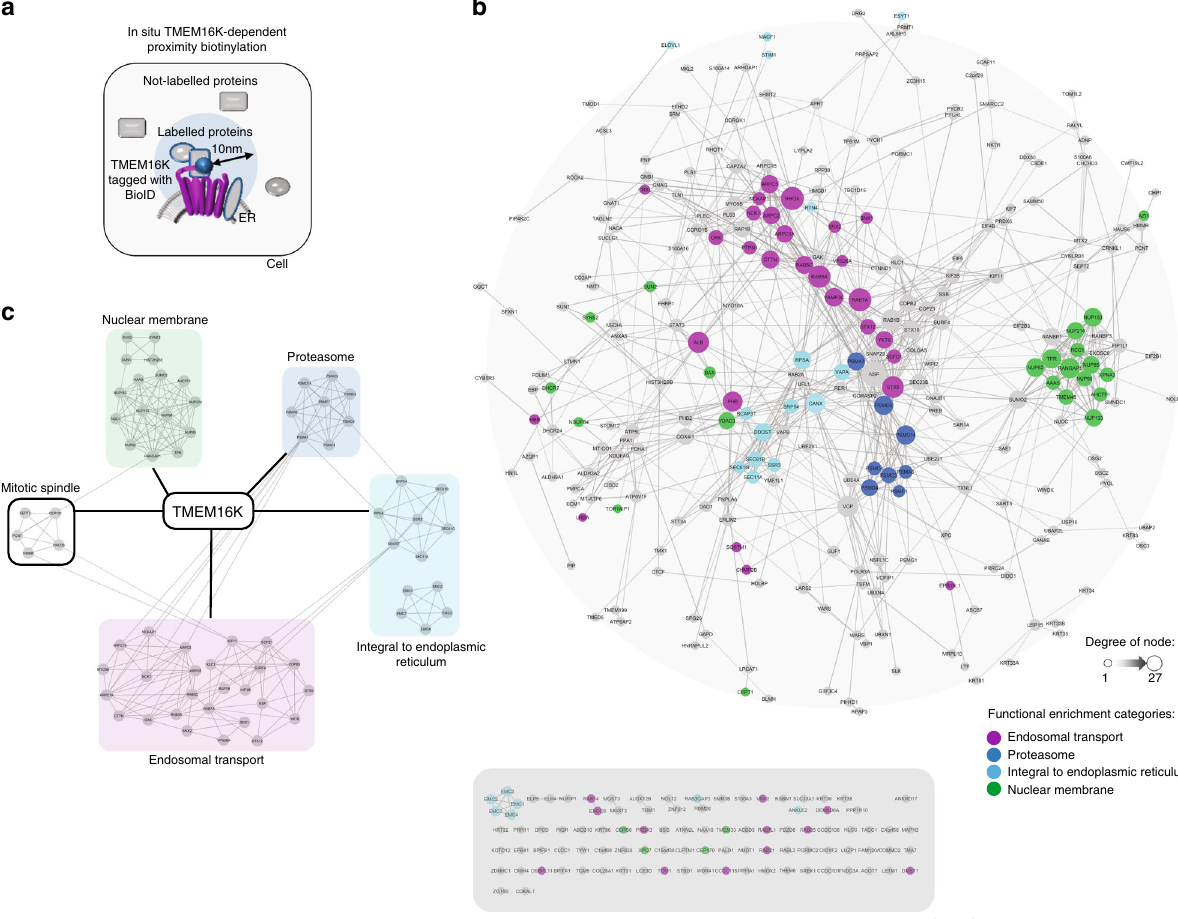
Fig. 2 Proteomic mapping of TMEM16K via in situ BioID-catalyzed biotin labeling fi nds endosomal transport as a major functional cluster. a Scheme of proteomic mapping of protein complexes surrounding TMEM16K in the radius of 10 nm via in situ proximity biotinylation. b TMEM16K proteome candidate list is visualized as a protein-protein interaction network using the String protein interaction public database in Cytoscape. Candidates without known protein-protein interactions in the String database are represented on the bottom in the gray panel. TMEM16K is omitted from this representation for simplicity. Functional enrichment based on the GO terms was calculated using the String app in the Cytoscape and the major identi fi ed categories of functional enrichment were overlayed on our candidates with color-code. Purple: Endosomal transport (False Discovery Rate (FDR) p value = 2.49E − 4), endosome to Golgi retrograde traf fi cking (FDR p value = 0.0096); Cyan: ER membrane protein complex (FDR p value = 1.5E-5), protein localization to endoplasmic reticulum (FDR p value = 0.0026); Green: nuclear membrane (FDR p value = 1.28E − 6), nuclear pore (FDR p value = 3.38E − 9);